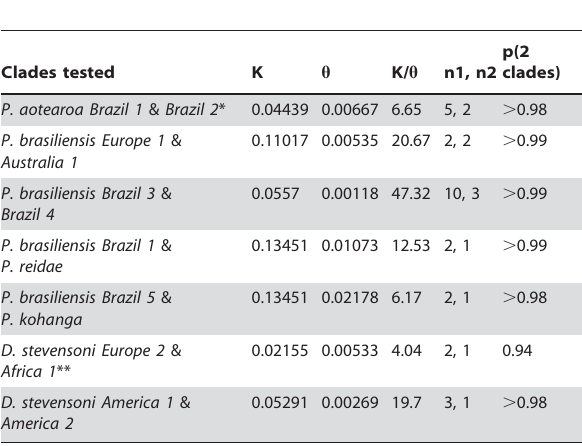
Table 2. Summary of results of K/ h tests for darwinulid species with the COI data